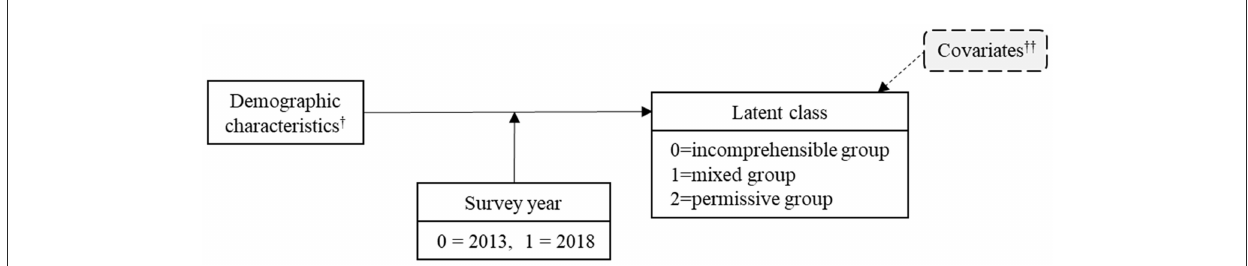
FIGURE3 Moderation model. Survey year (2013, 2018) as a moderator in the relationship between each sociodemographic characteristics and latent class. † (a) Education, (b) Monthly income, (c) Marital status, (d) Religion, (e) Experience of suicidal loss, (f) Interest in media reporting suicide, (g) Suicidal behavior. †† Covariates: age,